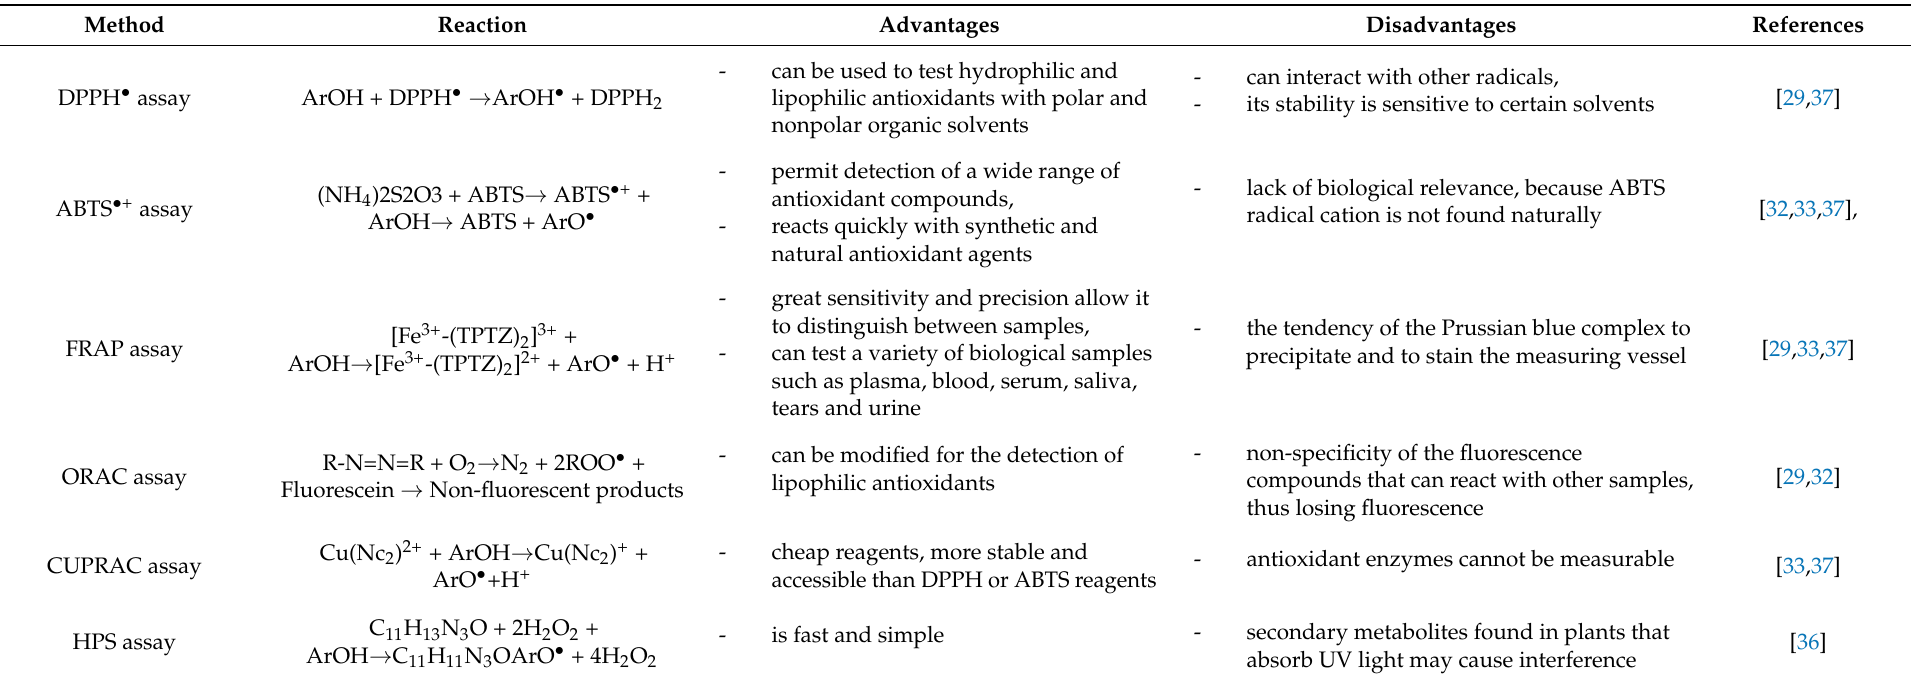
Table 1. Common assay for antioxidant activity, their reaction, advantages and